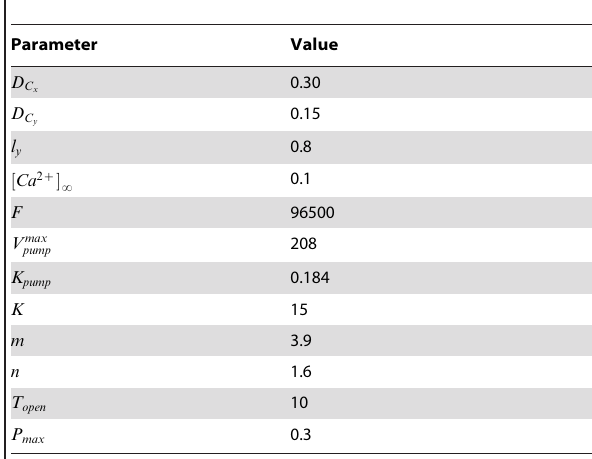
Table 1. Standard parameter